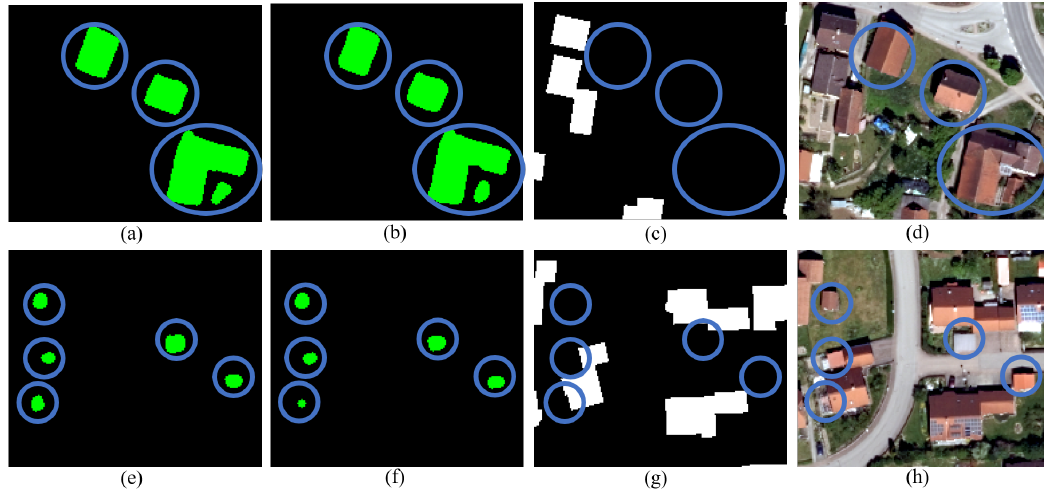
Figure 5. The new undocumented buildings in Ansbach obtained from (a), (e) Trained model 1, (b), (f) Trained model 2, and their